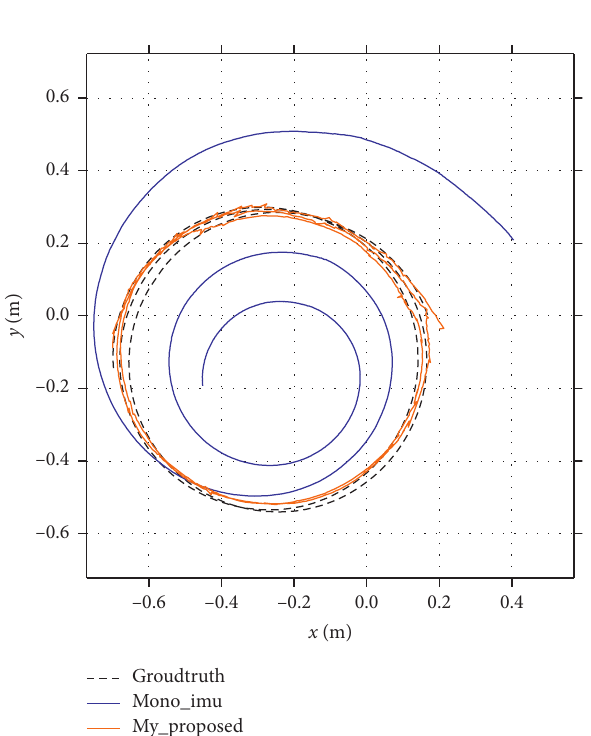
Figure 4: Comparison of trajectories and truth values of the two algorithms.